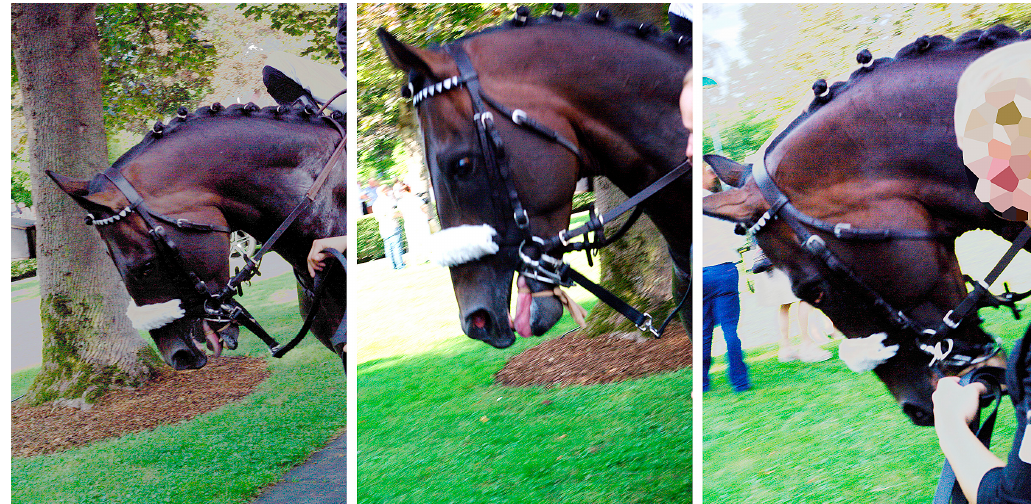
Figure B2. Images 4–6 of eight images of a thoroughbred with a tongue-tie taken on race day while the horse was led past the photographer/researcher in the mounting yard.